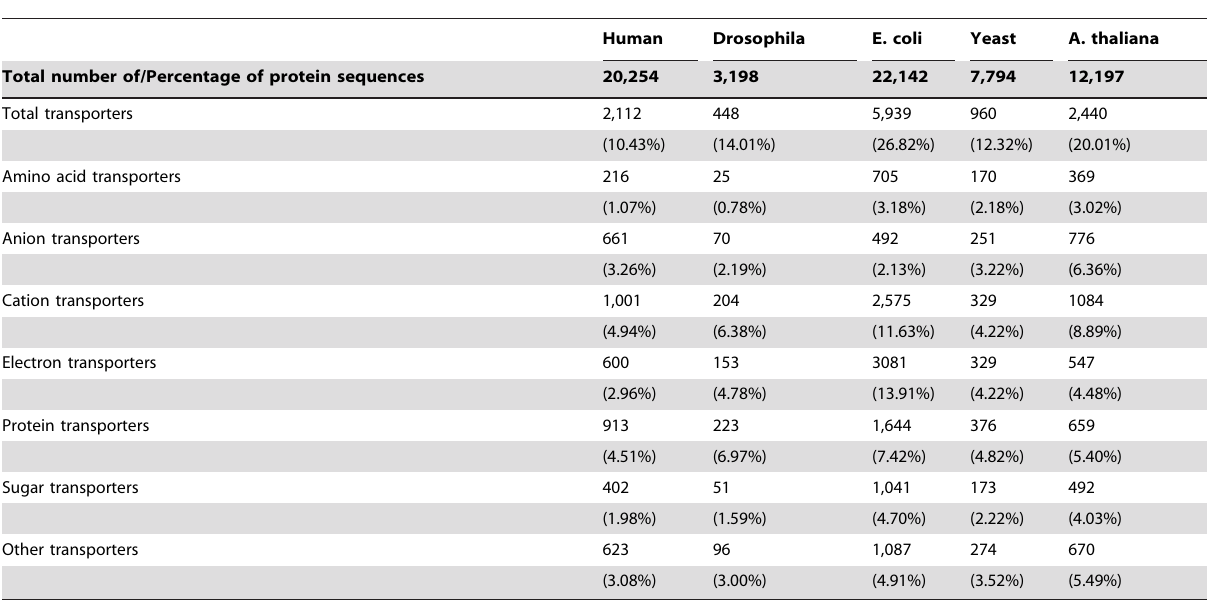
Table 12. The number of predicted transporters in Human, Drosophila, E. coli , Yeast and A. thaliana .